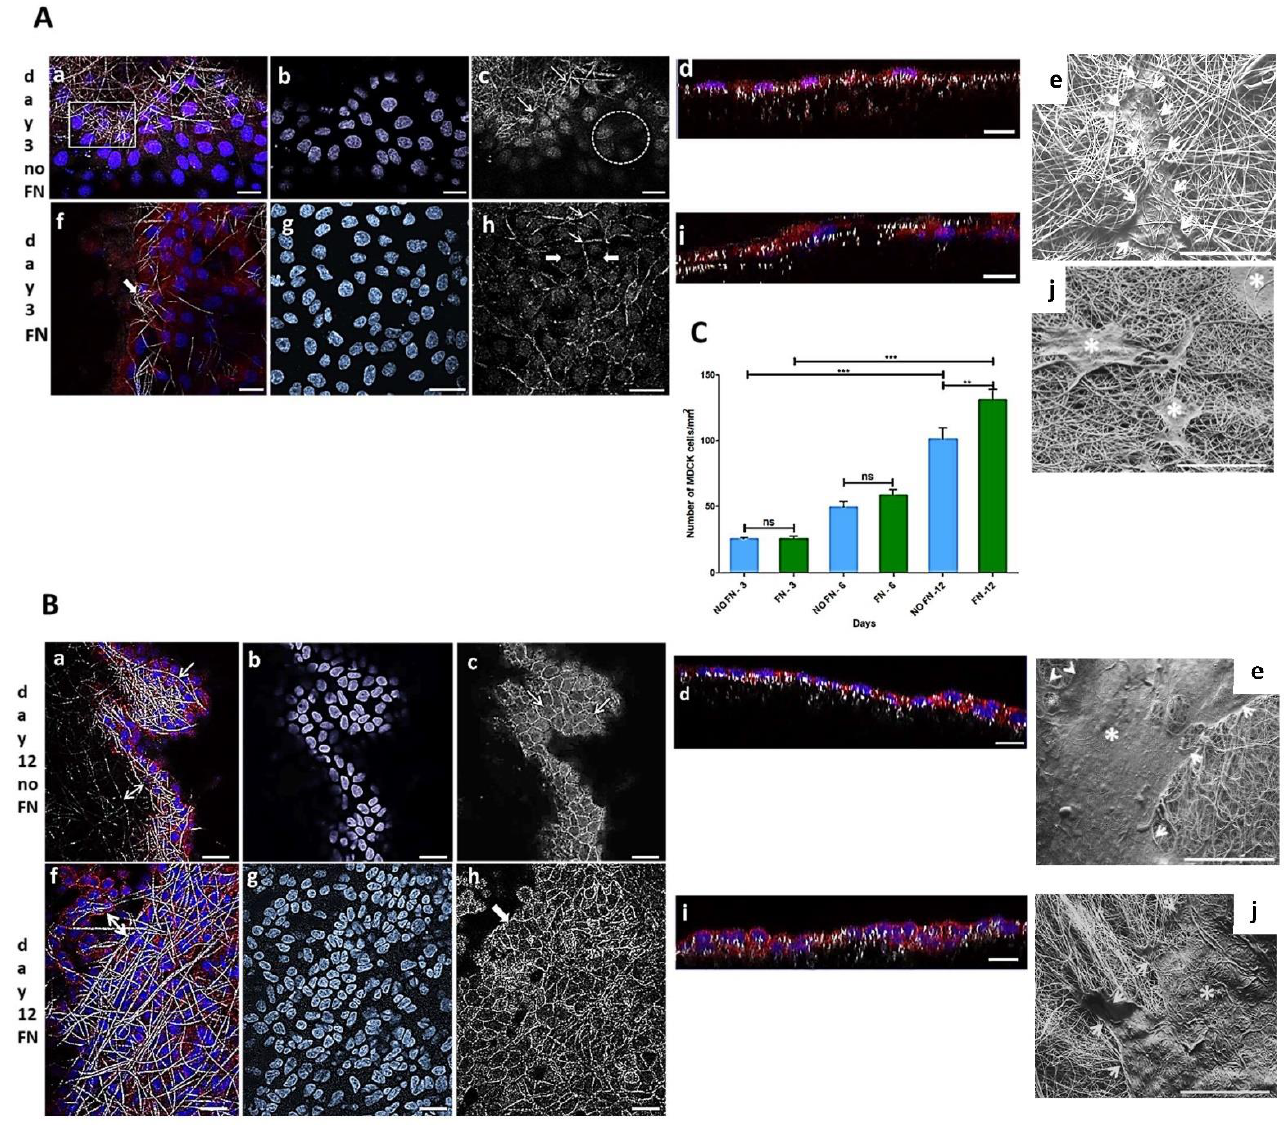
Figure 1. Representative images of MDCK cells cultured onto fibronectin-coated (FN) or uncoated (no-FN) PLGA membranes. ( A , B ): Confocal Laser Scanning Microscopy images of cells after 3 and 12 days, stained with Hoechst (blue) and phalloidin conjugated to Alexa 568 (red); ( C ): Graphical analysis. ( Aa ): Merge image of cells among no-FN PLGA fibers (arrow, square) after 3 days; ( Af ): Merge image of FN PLGA fibers and cells (white arrow) after 3 days. ( Ab , Ag ): Equivalent fields from ( Aa , Af ) processed on Image J software to visualize nuclei. Note the different organization of nuclei following the fibers after 3 days. ( Ac ): confocal images of phalloidin staining of no-FN coated fibers after 3 days ( Ac , arrows). Note few circumferential actin belt staining revealing adhesions between cells (circle) in comparison with FN membranes ( Ah ) after 3 days showing more adhesions between cells (thin arrows), among cells without adhesions (thick arrows). ( Ad , Ai ): cells in a X-Z plane after 3 days forming a monolayer with less cells. Scale bars ( Aa – Ai ): 20 µm. ( Ae , Ai ): SEM images of no-FN or FN membranes exhibiting isolated cells onto the fibers after 3 days (white arrows and asterisks). Scale bars: 100 µm. ( Ba , Bf ): Merge image of cells after 12 days. Note fibers and cells among the fibers on no-FN or FN, respectively (white arrows and double arrows). ( Bb , Bg ): Equivalent fields from ( Ba – Bf ) showing a greater number of nuclei with a differential organization after 12 days. ( Bc , Bh ): Equivalent fields from ( Ba – Bf ) showing the increase in circumferential actin belts demonstrating formation of adhesions between cells exhibiting a cuboidal morphology onto PLGA fibers. Note a greater number of cells onto FN coated membrane after 12 days. ( Bd , Bi ): cells in an X-Z plane after 12 days showing more proliferation. Scale bars ( Ba – Bi ): 20 µm. ( Be , Bj ): SEM image showing cells covering the majority of the membrane after 12 days (white arrows and aster-